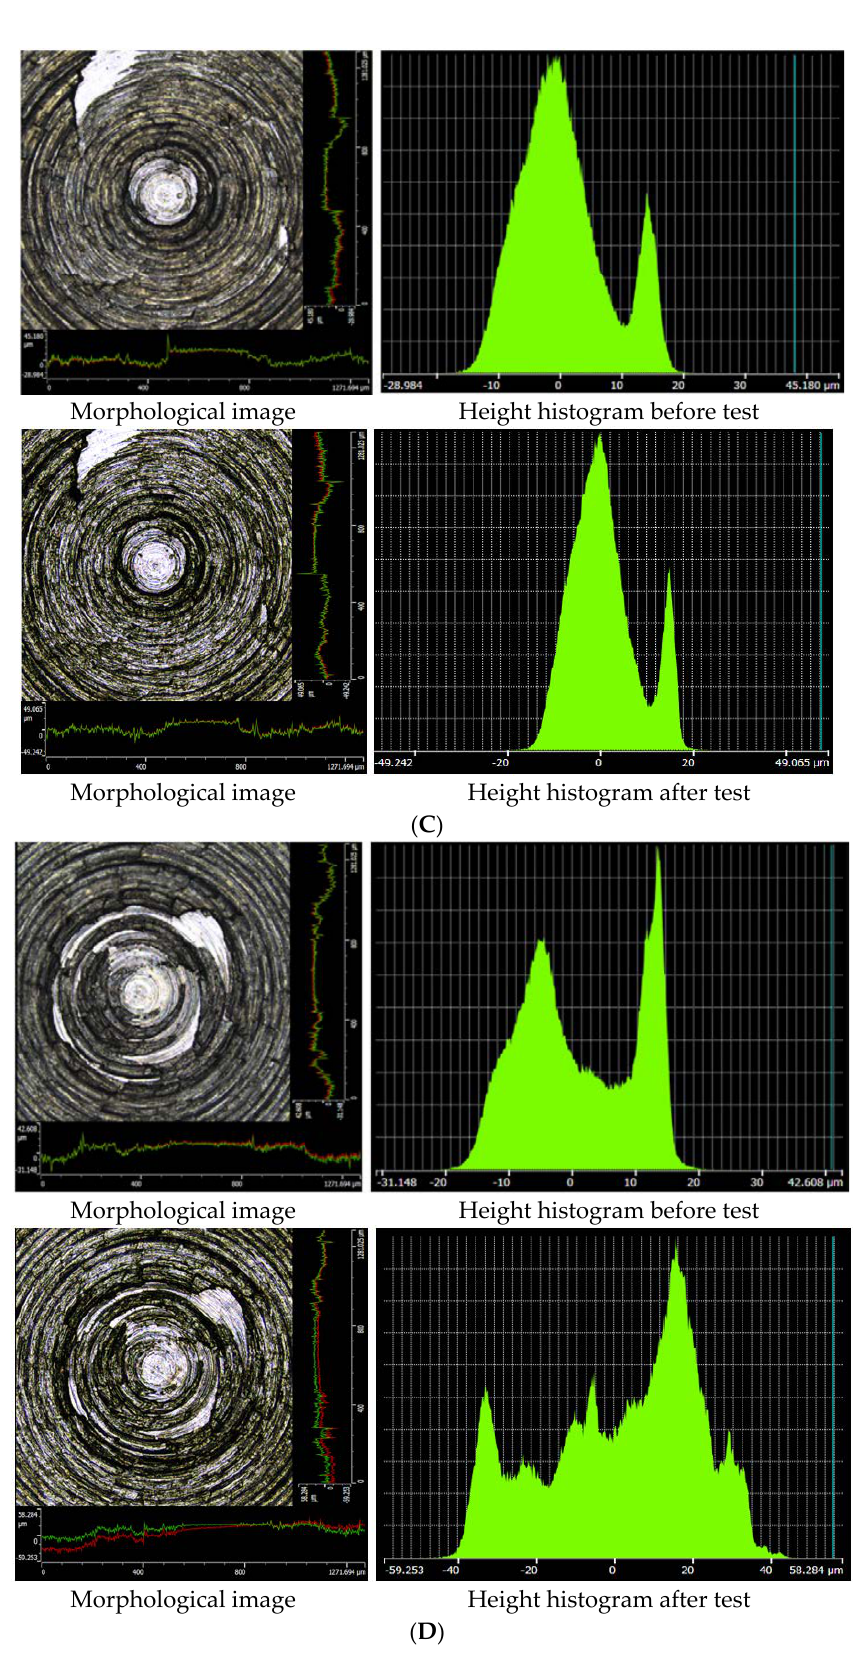
Figure 4. A comparison of the surface morphology changes in the mixer chamber wall (left is the morphological image, right is the height histogram (( A ): 0 phr MoDTC; ( B ): 3 phr MoDTC; ( C ): 6 phr MoDTC; ( D ): 9 phr